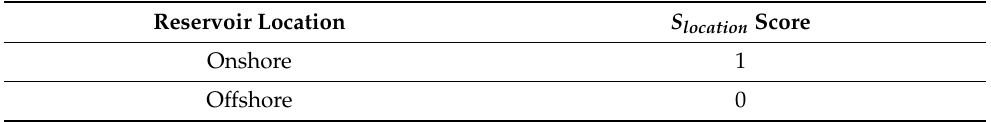
Table 3. The assessment rules of the reservoir